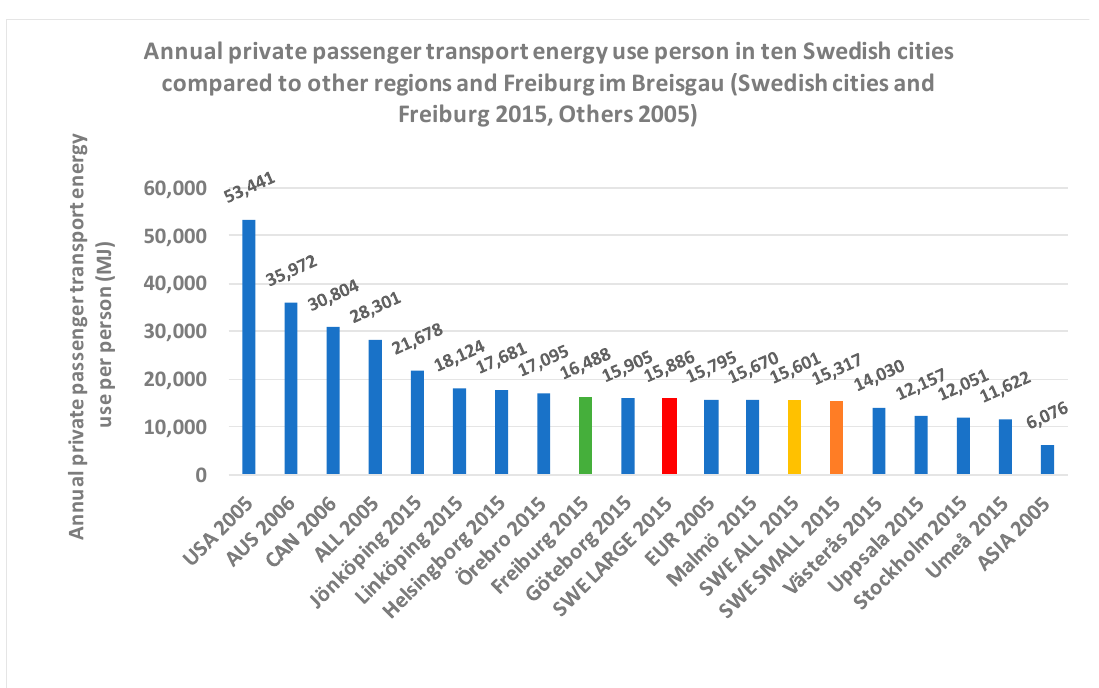
Figure 1. Annual private passenger transport energy use per person in ten Swedish cities (2015), and in American, Australian, Canadian, European and Asian cities (2005–2006).